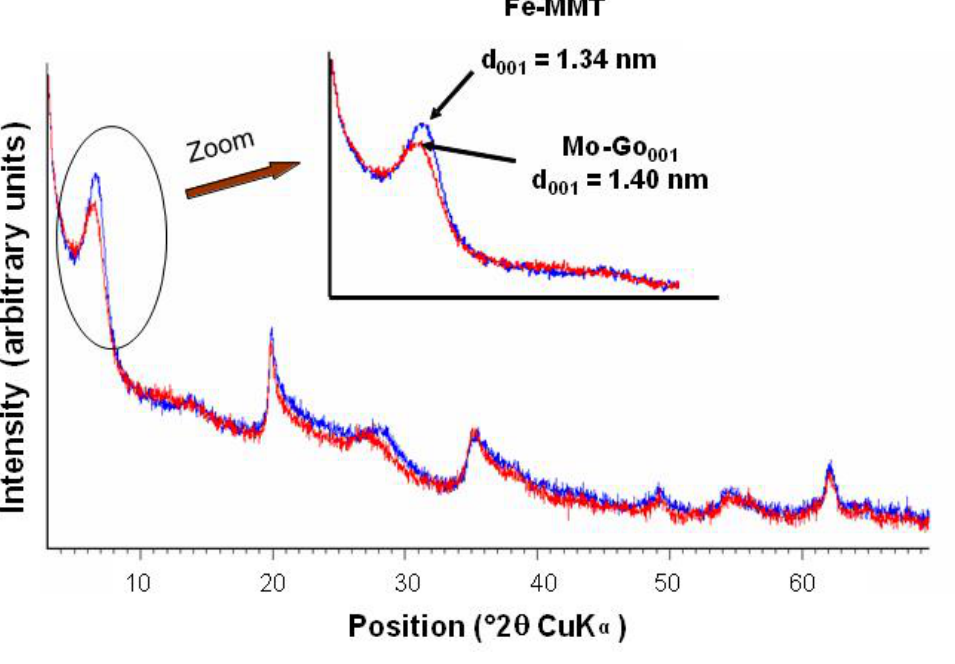
Figure 3. Differential Thermal Analysis (DTA) curve of Mo-Go